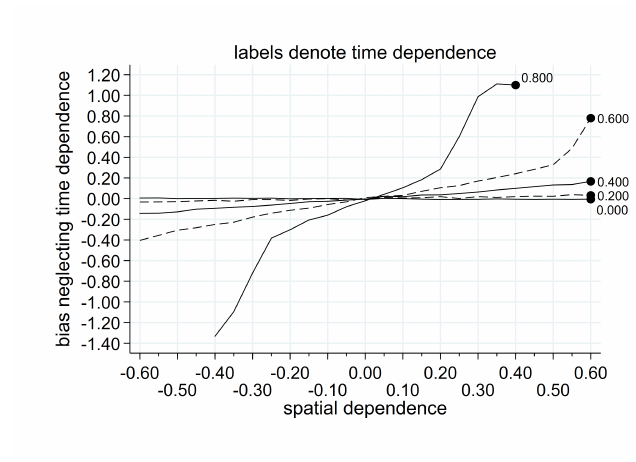
Figure 2: Bias of Team Spatial neglecting the time dimension. The vertical axis describes λ the horizontal axis depicts λ 0 . Labels denote spatial dependence in the DGP ( γ 0